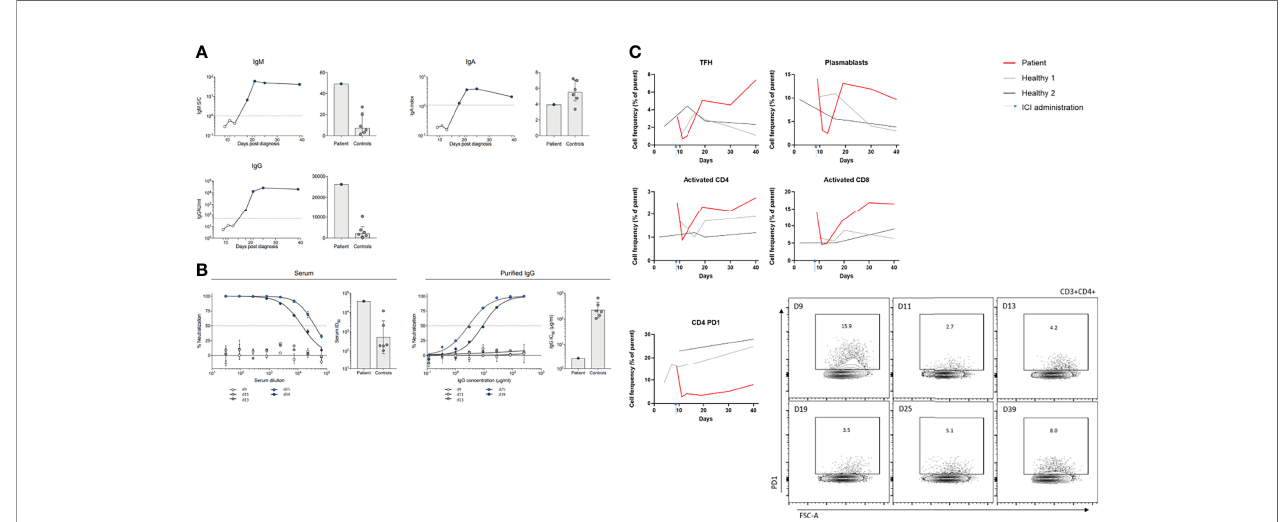
FIGURE 2 | Cellular and humoral immune trajectory during SARS-CoV-2 infection and immune checkpoint inhibition treatment. Cellular and humoral immune responses to SARS-CoV-2 infection were monitored on D9 prior to pembrolizumab infusion, and on D11, D13, D19, D25, and D39 and compared to controls (SARS-CoV-2- positive adult individuals with mild disease and without cancer disease). (A) Serum antibodies (IgM, IgA, and IgG) measured by ELISA (IgA, Euroimmun ELISA; IgM and IgG, Abbott Alinity CMIA) targeting SARS-CoV-2 became detectable by D18 post SARS-CoV-2 diagnosis. (B) SARS-CoV-2-neutralizing activity was measured, determined by a lentivirus-based pseudovirus neutralization assay as previously described (8) for serum and puri fi ed serum IgG from D25 on. Six patients with mild COVID-19 disease served as control for (A, B) [right panels; sample acquisition D20 to 30 after PCR con fi rmation of SARS-CoV-2 infection (8)]. (C) Lymphocyte subsets and their expression of activation/differentiation markers (Plasmablasts [(CD20 - CD38 high )%CD19 + ], T follicular helper cells [TFH; PD1 + ICOS + ], activation status of CD4 and CD8 T cells [HLA-DR + CD38 + ], and PD1 expression on CD4 + T cells) were determined by fl ow cytometry. Two subjects with mild COVID-19 disease served as control (sample acquisition for the same period as the patient). Exemplarily, fl ow cytometry data are shown for CD4 + PD1 + T